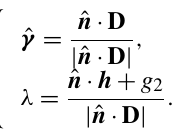
Table 1. User input items to the UBER code. Input items Comments ∂ α ln G Vector field to specify the coordinate system D αβ , h α , S , v Coefficients to define the PDE g 0 (x α ) Function to provide the initial condition ψ(t,x α ) = 0 Equation to define a boundary piece’s geometry g ∗ (t,x α ) Function to provide the boundary condition, ∗ = 1 or 2 depending on the type of the boundary ˆ n (x α ) Inward unit normal vector only for ∂(cid:127) \ ∂ 1